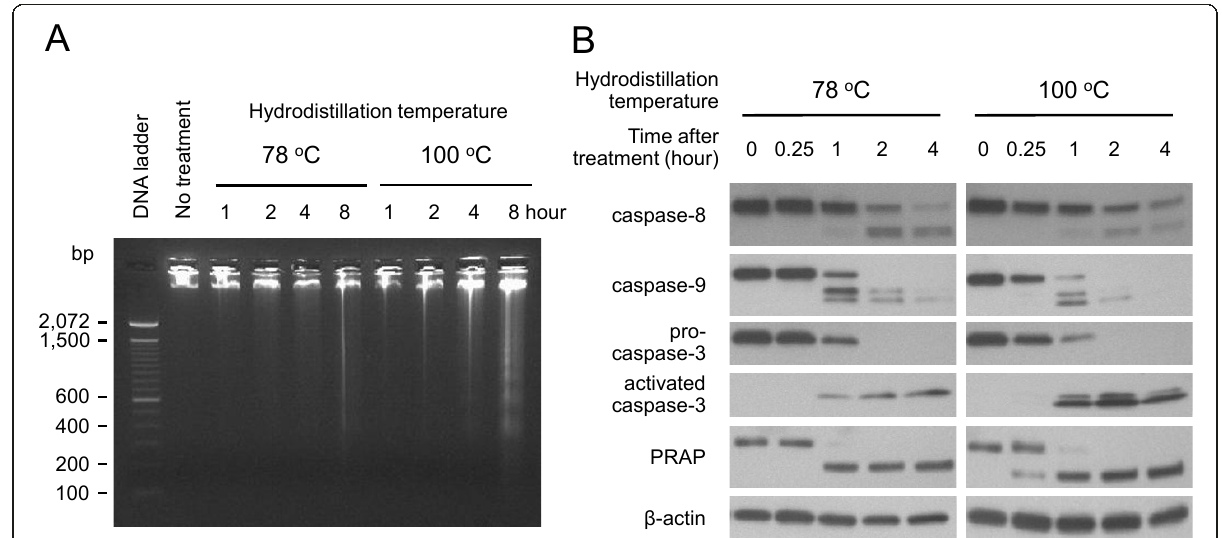
Figure 4 Boswellia sacra essential oil-induced apoptosis in human breast cancer cells . Human breast cancer MDA-MB-231 cells were seeded at the concentration of 5x10 5 cells/60 mm tissue culture plates for adherence and subjected essential oils (1:800 and 1:1,200 dilutions of 78 and 100 o C, respectively) treatment. Both genomic DNA and total cellular proteins were isolated at specific time points as indicated. (A) Essential oil-induced genomic DNA fragmentation. (B) Essential oil-activated pro- and cleavage of caspases. Experiments were repeated at least twice and representative results are